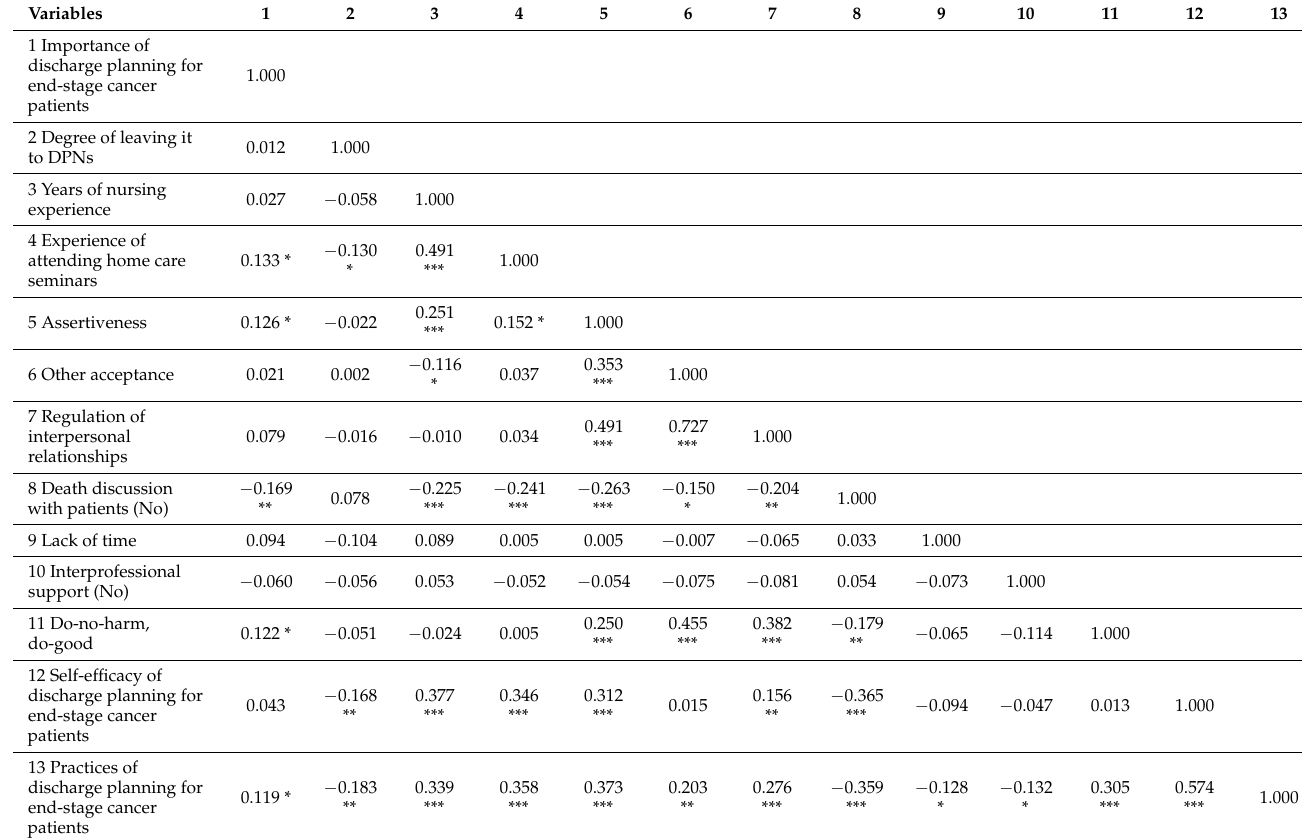
Table 3. Correlations among variables (N =